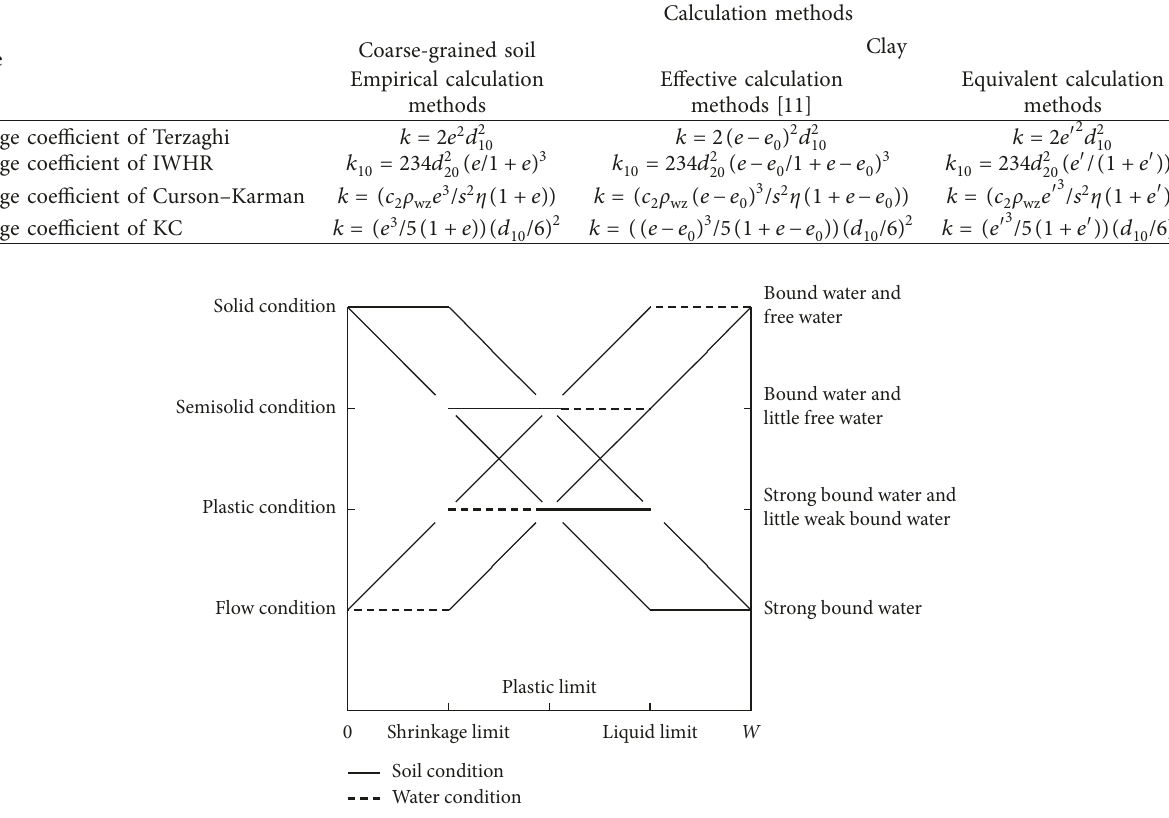
Figure 5: Liquid-plastic limit condition of